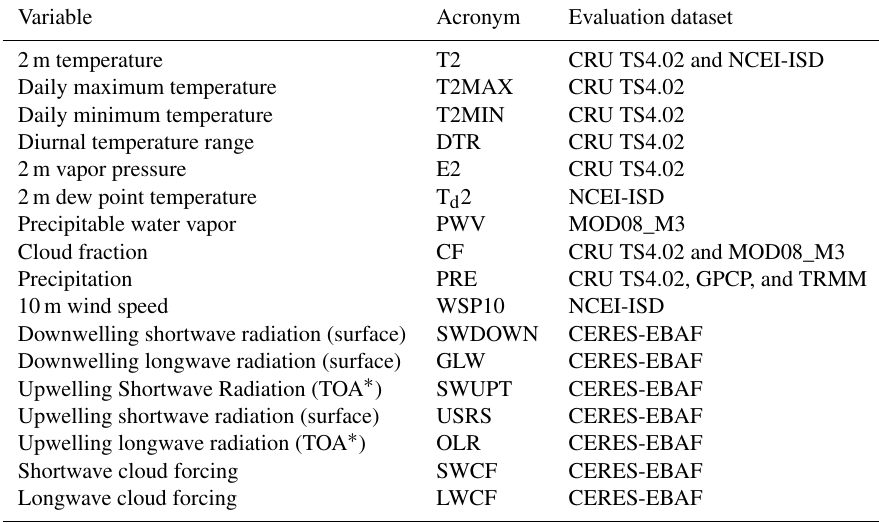
Table 9. Evaluated variables and evaluation